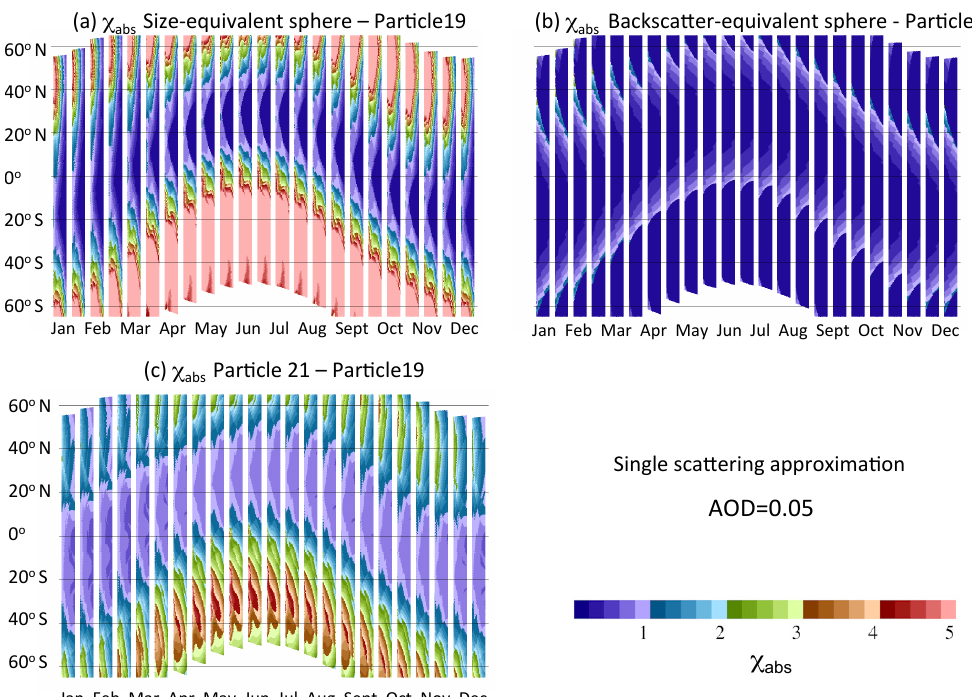
Fig. 14. χ 2 calculated for MISR red and NIR wavelengths only, as in Fig. 13, comparing MISR Particle 19 and the three other particles abs using the single-scattering approximation: (a) Size-equivalent sphere (identical to Fig. 13a), (b) backscatter-equivalent sphere, and (c) MISR Particle